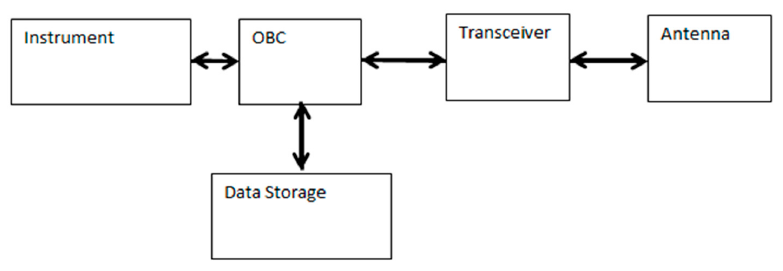
Figure 31. Typical CubeSat Telecommunication Systems [7].